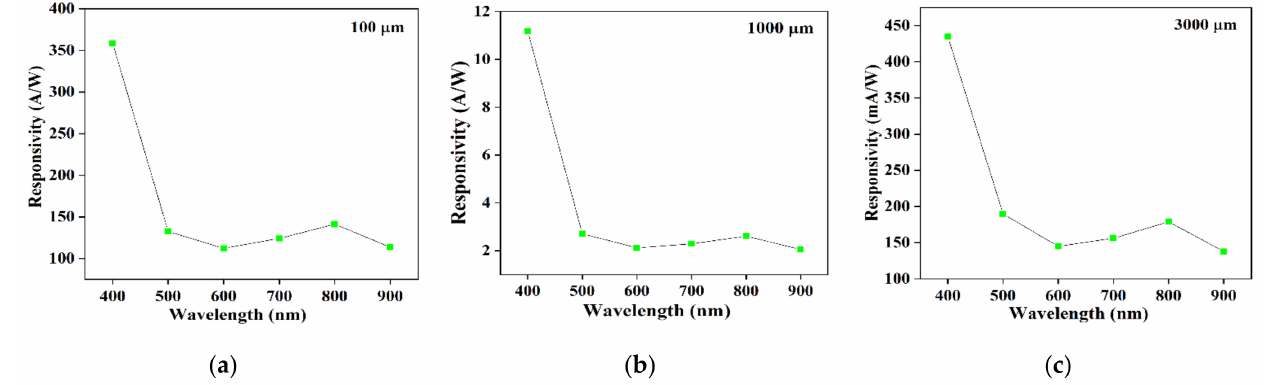
Figure 9. Responsivity R λ ( λ ) of graphene/IDE devices as a function of the wavelength (400 to 900 nm). ( a ) 100 µ m; ( b ) 1000 µ m; and ( c ) 3000 µ